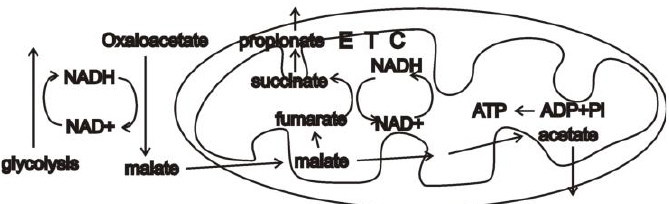
Figure 1. In the absence of oxygen, many metazoans carry out malate dismutation. Cytosolic NADH from glycolysis is reoxidized by converting oxaloacetate into malate. Malate is imported into mitochondria, where some of it is oxidized and some reduced. Thus-formed mitochondrial NADH powers a truncated electron transport chain (ETC) running the Krebs cycle backwards and and